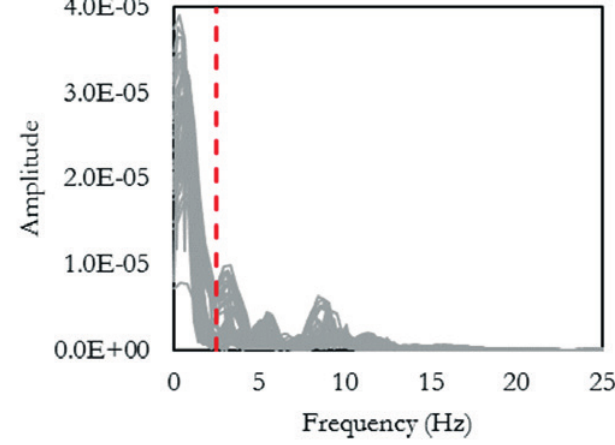
Fundamental frequency of the structure obtained experimentally Response of the structure in the frequency